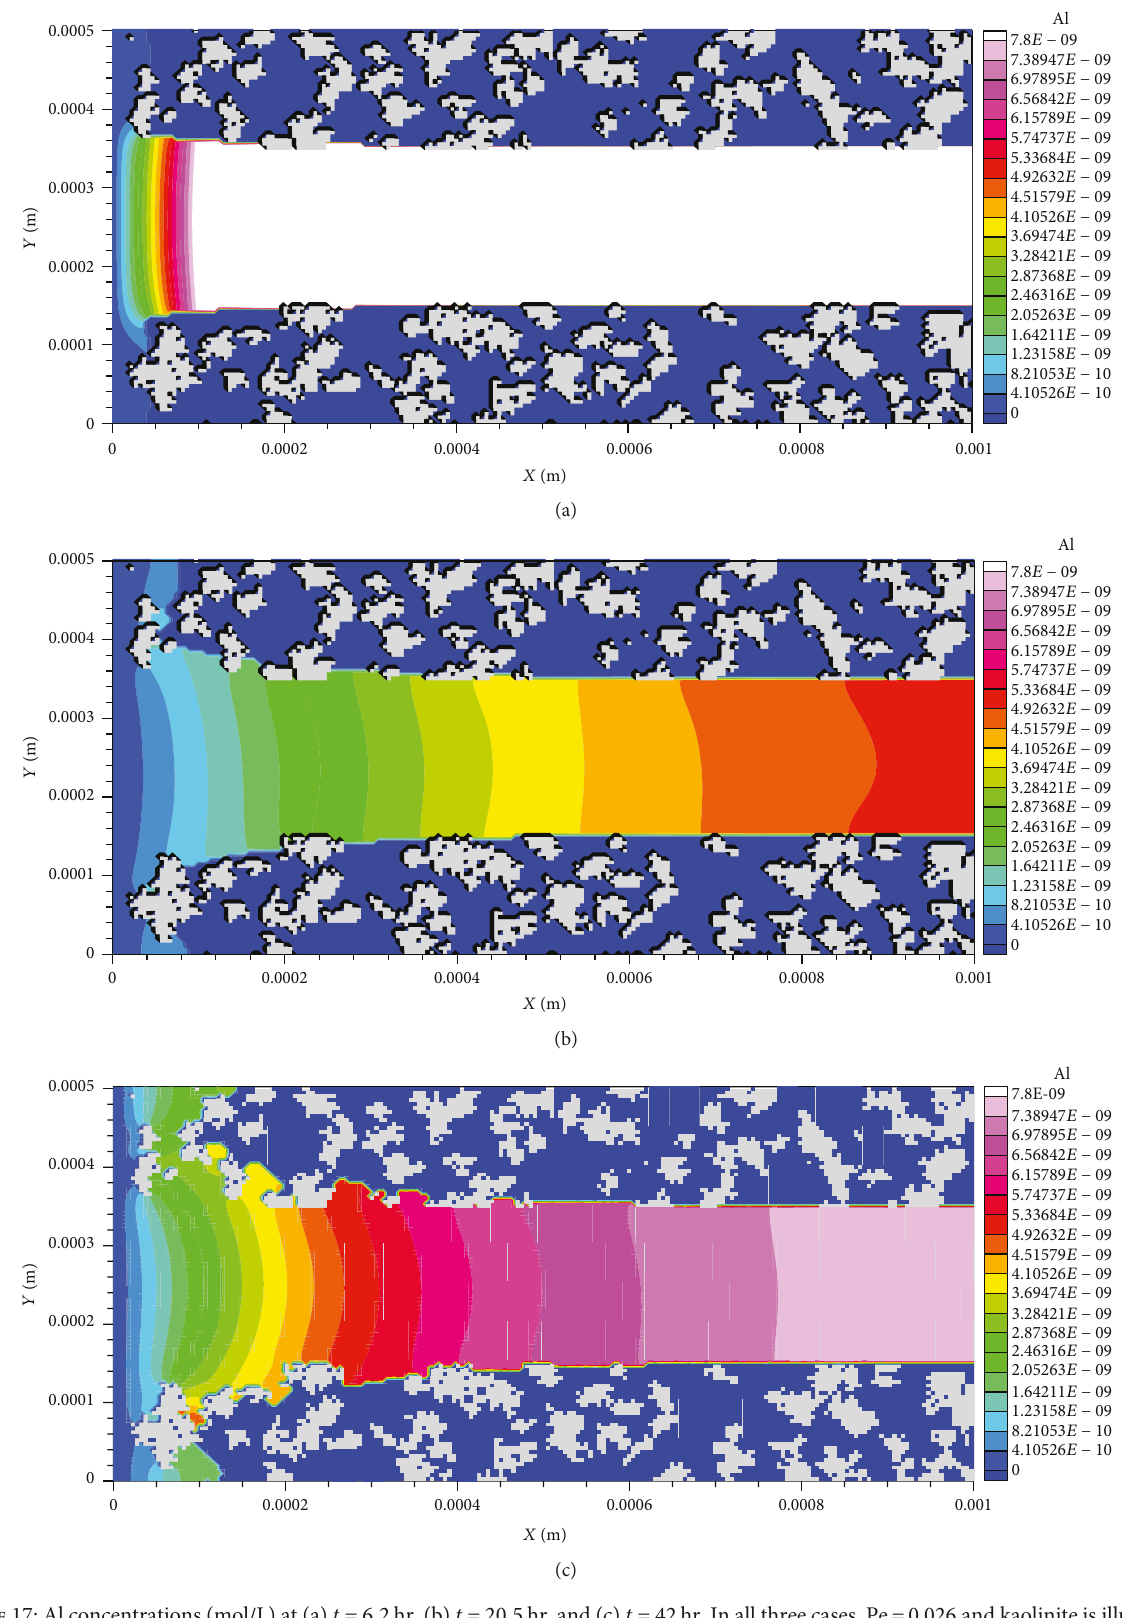
Figure 17: Al concentrations (mol/L) at (a) t = 6 2 hr, (b) t = 20 5 hr, and (c) t = 42 hr. In all three cases, Pe =0.026 and kaolinite is illustrated in light